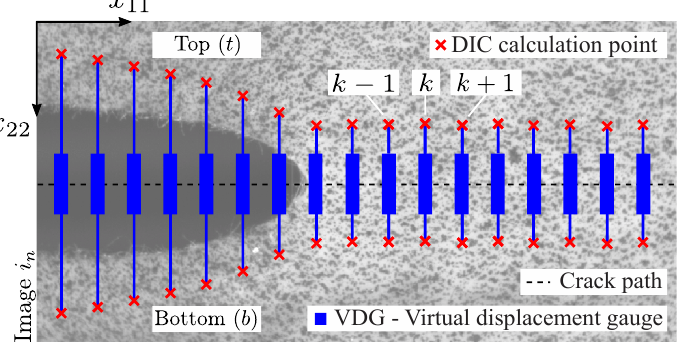
Figure 3. DIC-based virtual displacement gauge